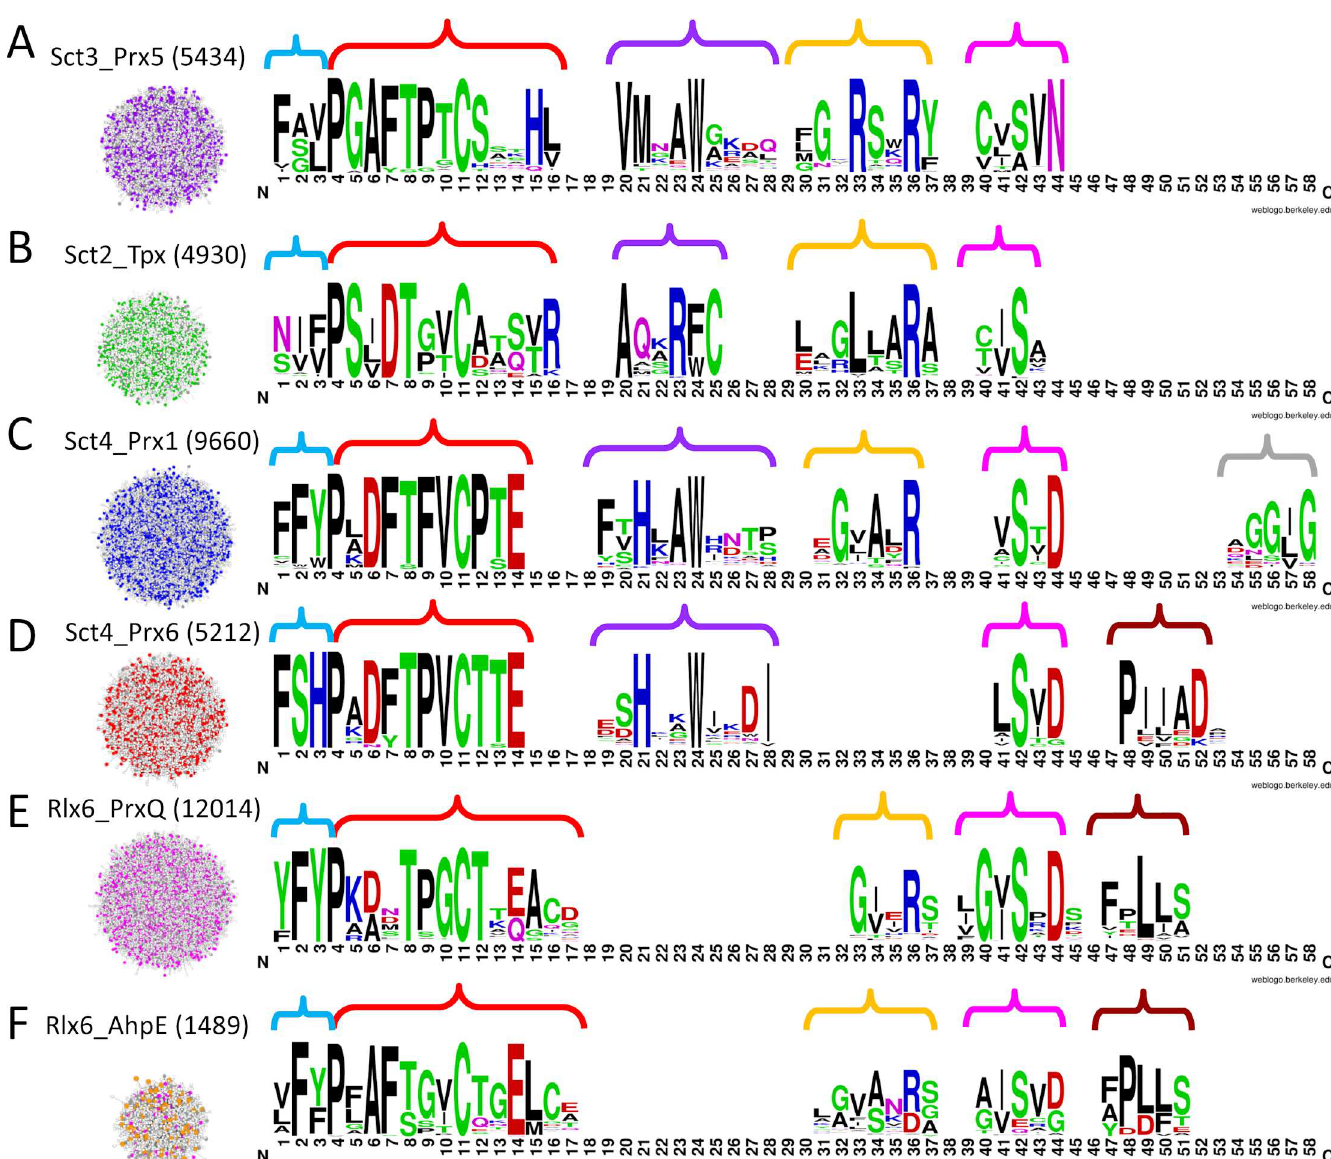
Fig 5. Signature conservation graphs highlight potential specificity determining positions (SDPs) in each of the six Prx subgroups. Pseudo- signatures(see Methods)for the significantly scoringproteins(post cross hit analysis)in each MISST group were usedto construct signatureconservation graphs(signaturelogosof the active site profiles). Letter height indicates the residueconservation in that position. Coloredbraces indicatemotifs discussed in the text. The clusters on the left show the proteinsusedto create the signaturelogos, coloredby previouslydefinedsubgroup;the numberin parenthesis represents the numberof proteinsin each cluster. The signaturelogoswere created usingWebLogoversion 2.8.2 with default settings and with the y-axis not shown.